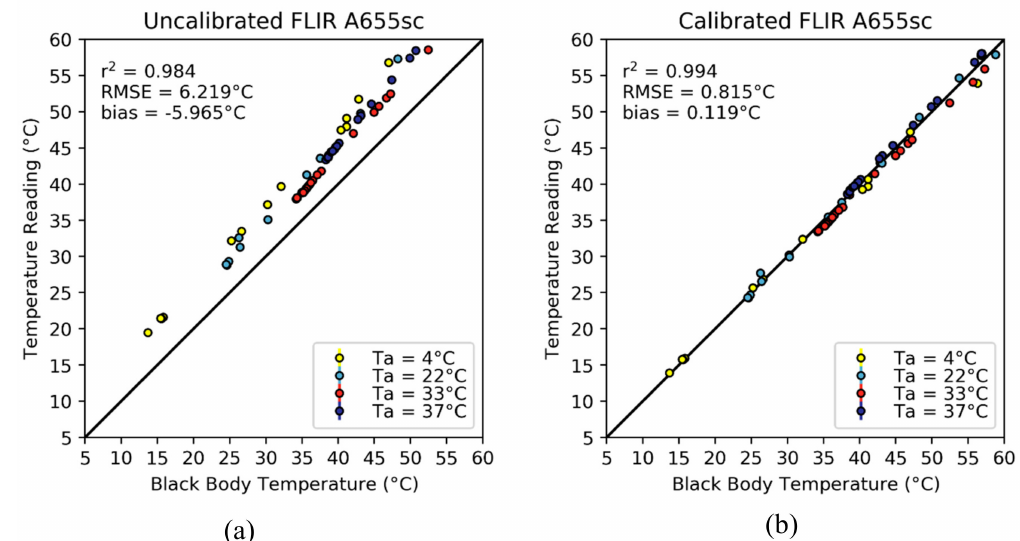
Figure 5. Scatterplot of the average temperature readings of the FLIR A655sc camera before ( a ) and after ( b ) calibration. Error bars are included to show the spread from the mean temperature value of each image and are three times the standard deviation of each observation. However, for the FLIR A655sc, the standard deviation was small and the error bars are visible only for a couple of samples when the black body temperature was ~45 ◦ C. The plots and the statistics were made from the evaluation dataset (n =